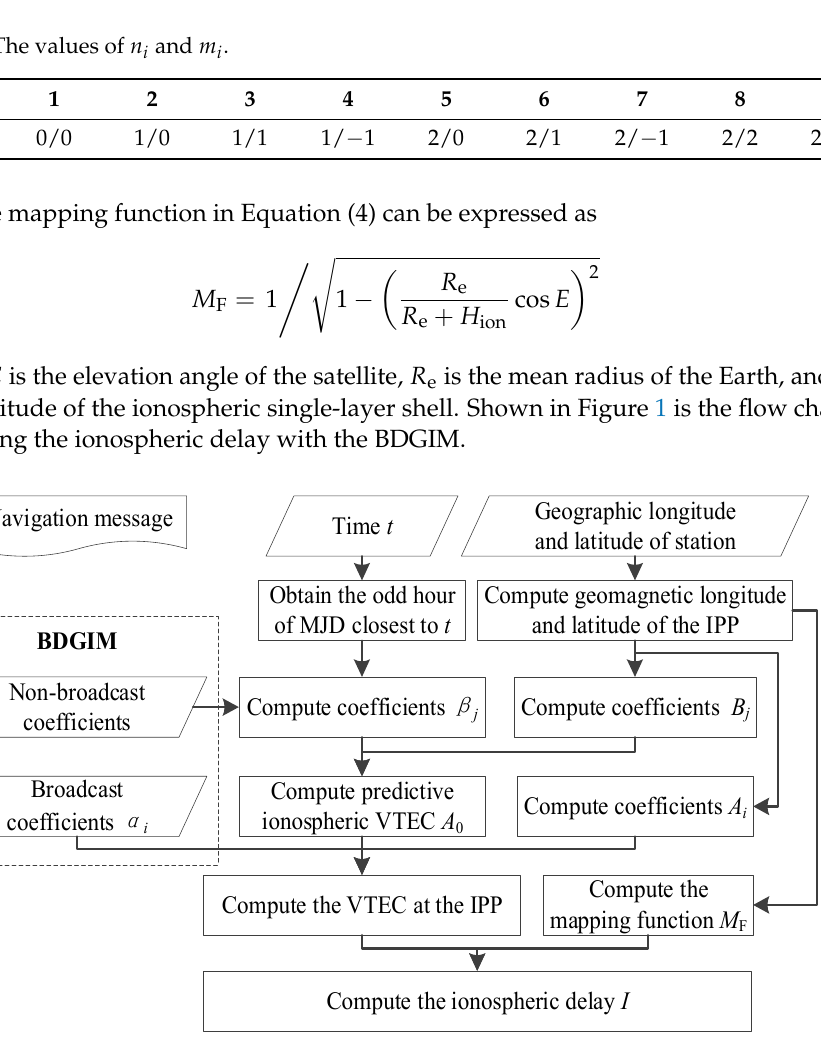
Figure 1. Computation of the ionospheric delay with the BDGIM.